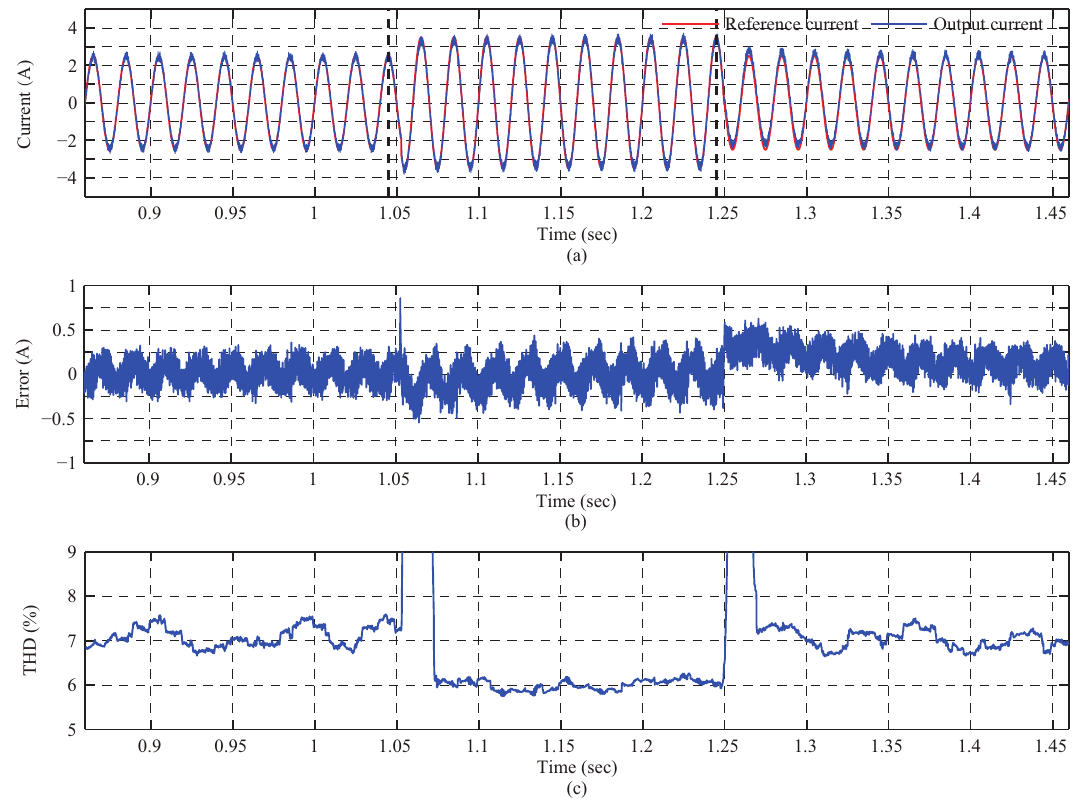
Figure 10. Instant response of proposed controller: ( a ) output current; ( b ) error; and ( c )